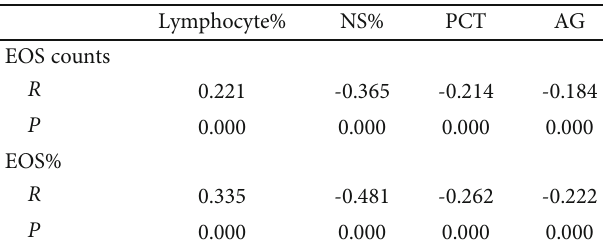
Table 4: The correlations between EOS counts/EOS% in blood